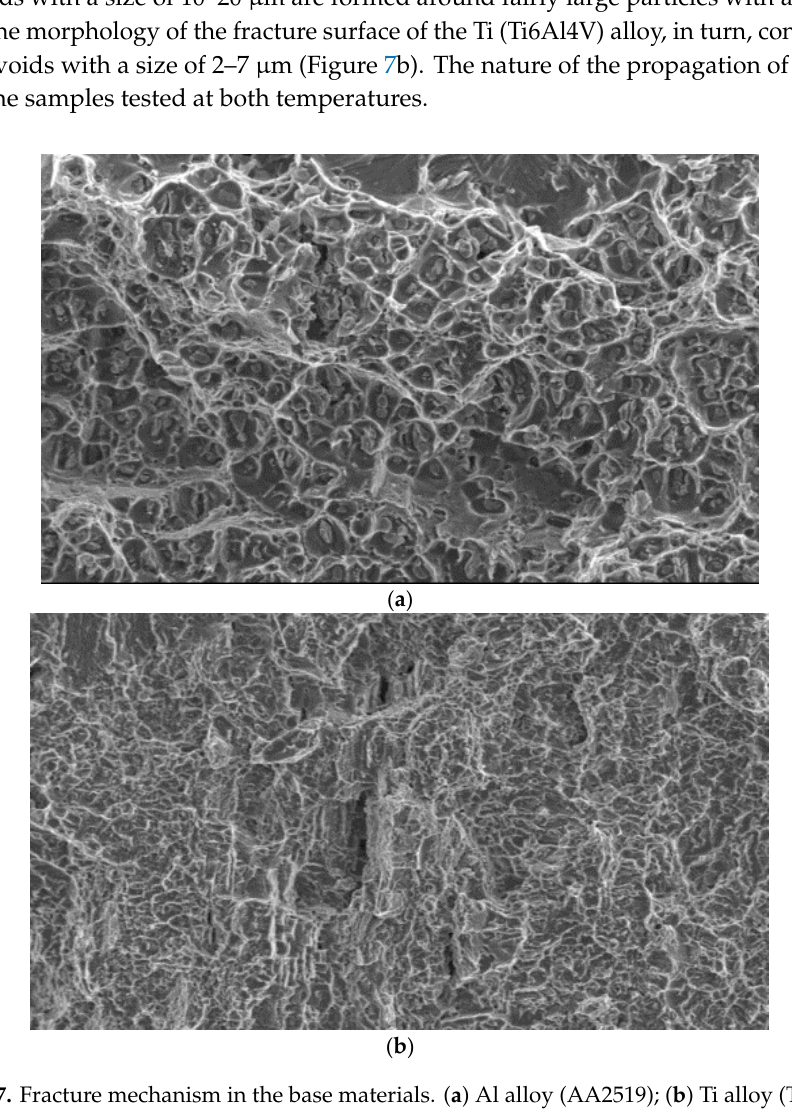
Table 2. The results of EDS analysis.